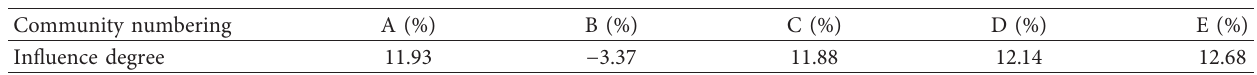
Table 2: The influence of the opening of the community on the traffic capacity of surrounding